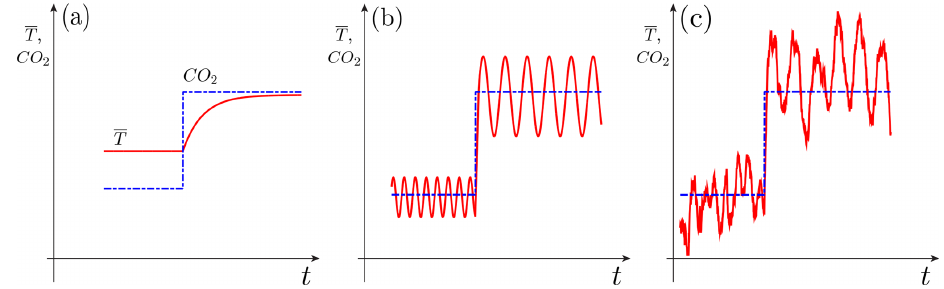
Figure 3. Schematic diagram of the effects of a sudden change in atmospheric carbon dioxide (CO 2 ) concentration (blue dashed and dotted line) on seasonally and globally averaged surface air temperature T (red solid line). Climate sensitivity is shown (a) for an equilibrium model, (b) for a nonequilibrium oscillatory model, and (c) for a nonequilibrium chaotic model, possibly including random perturbations. As radiative forcing (atmospheric CO 2 concentration, say) changes suddenly, global temperature ( T ) undergoes a transition. In panel (a) only the mean temperature changes, in panel (b) the mean adjusts, as it does in panel (a) , but the period, amplitude, and phase of the oscillation can also decrease, increase, or stay the same, while in panel (c) the entire intrinsic variability changes as well, including the distribution of extreme events. From Ghil (2017); used with permission from the American Institute of Mathematical Sciences, under the Creative Commons Attribution license.